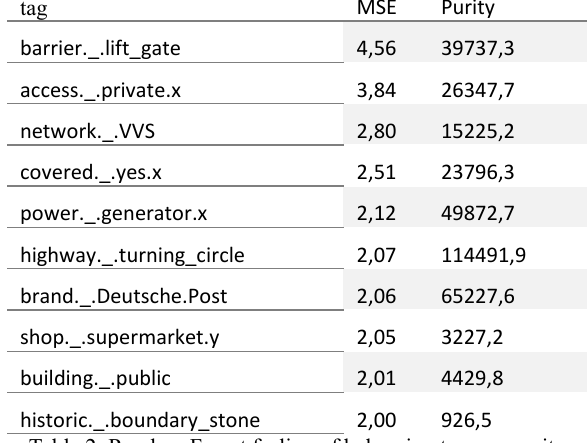
Table 2. Random Forest feeling of belonging to community